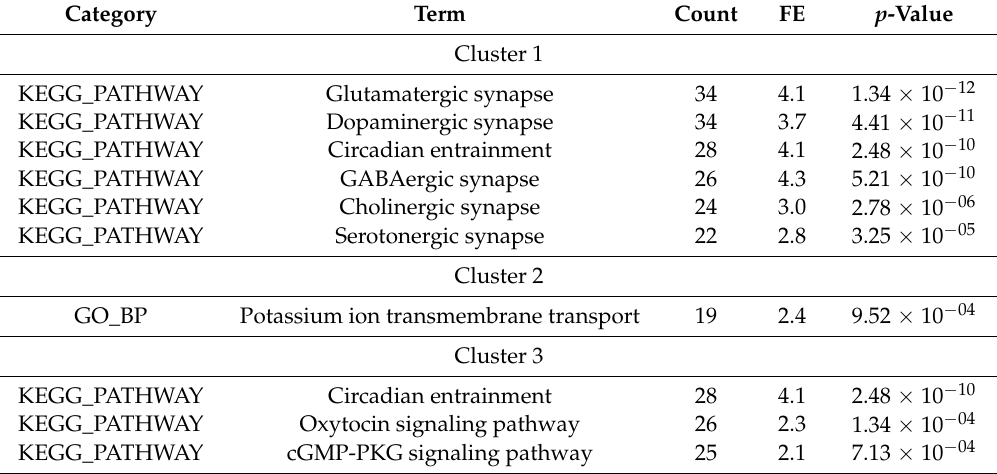
Table 3. Pathways significantly over represented in down-regulated DEGs in elderly vs. young